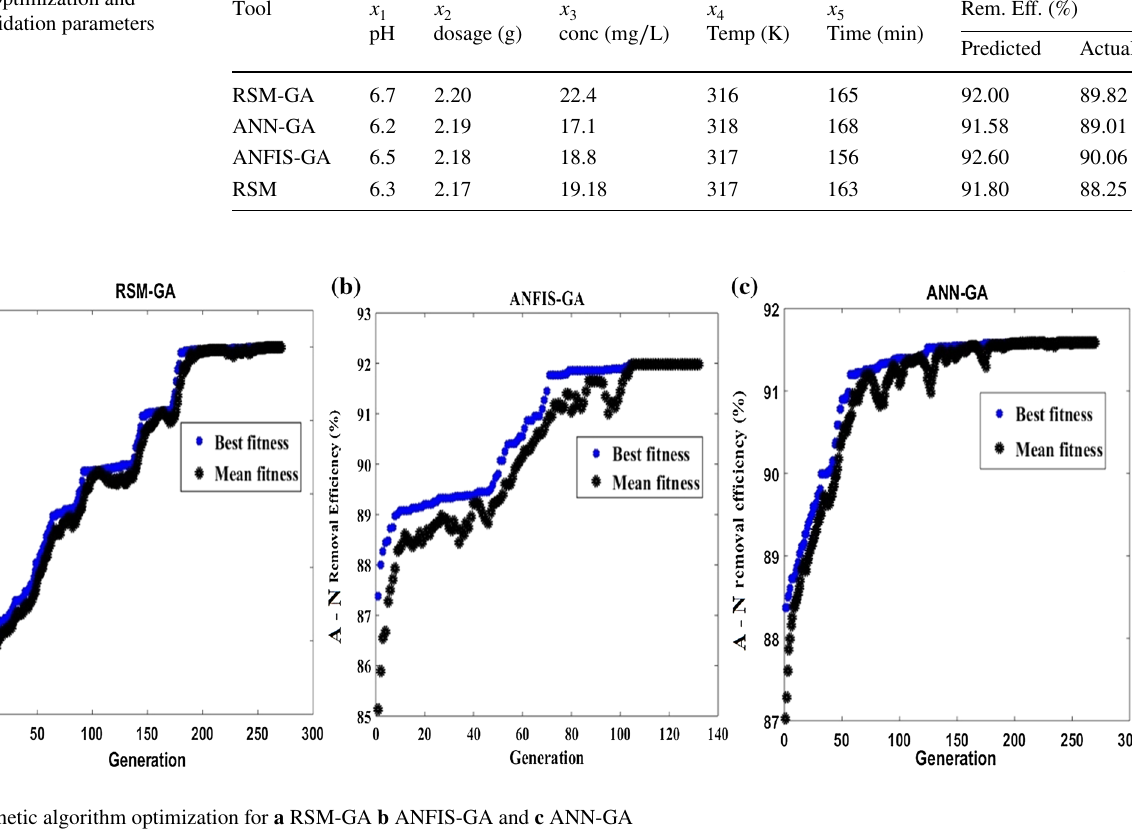
Table 8 Optimization and model validation parameters